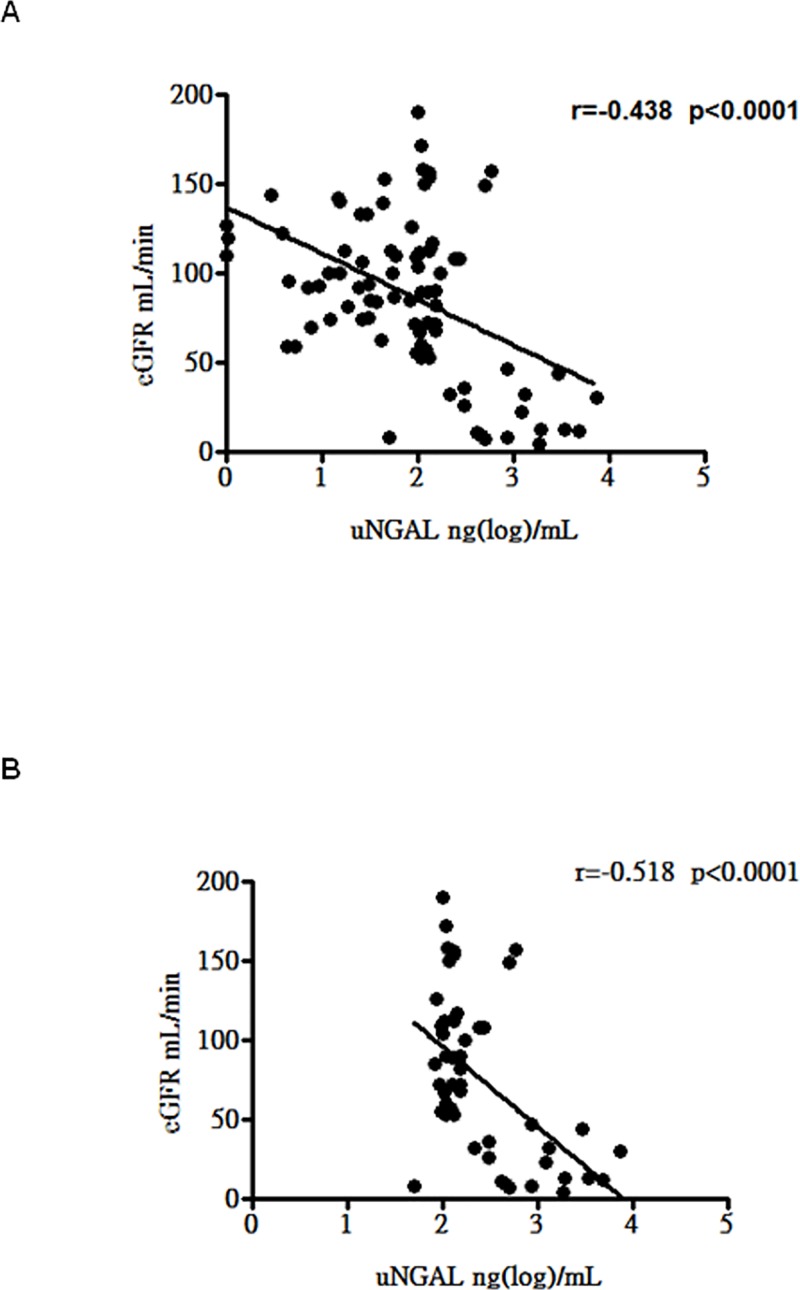
Correlations between eGRF and uNGAL level in all SLE patients and patients with LN.A. Correlation between eGRF and uNGAL level in all SLE patients. B. Correlation between eGFR and uNGAL level in patients with LN.